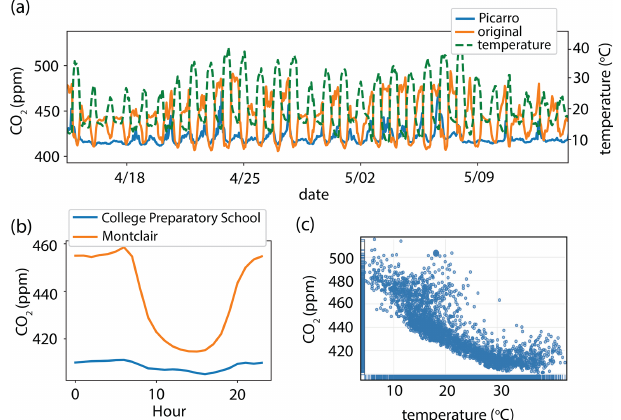
Figure 3. (a) CO 2 mixing ratios from May 2018 at Montclair and measured with a Picarro instrument at the Richmond Field Station supersite. (b) Montclair 2018 diurnal cycle compared with College Preparatory School. (c) Temperature dependence of CO 2 signal at